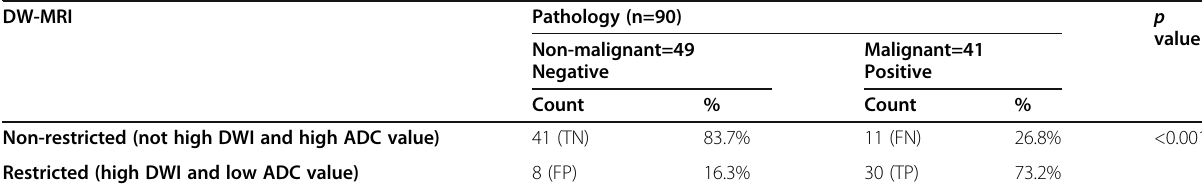
value Non-malignant=49 Malignant=41 Negative Positive Count % Count %